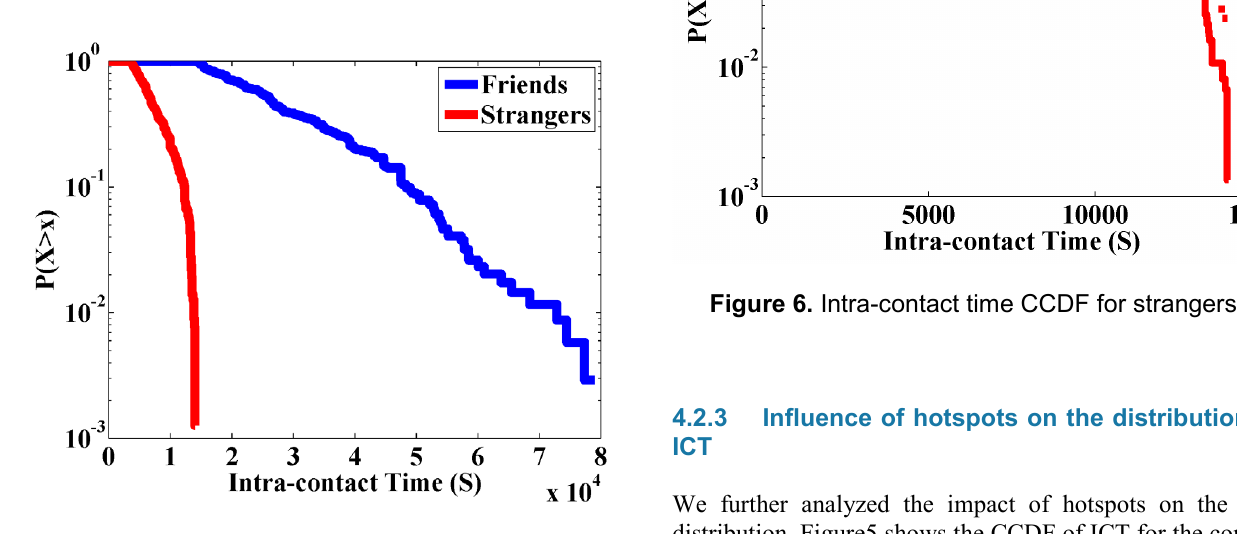
Figure 4. Intra-contact time CCDF for friends and strangers.